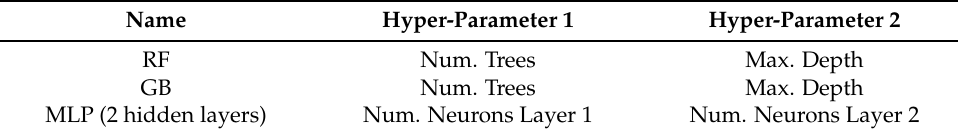
Table 3. ML algorithms together with hyper-parameters we have considered.